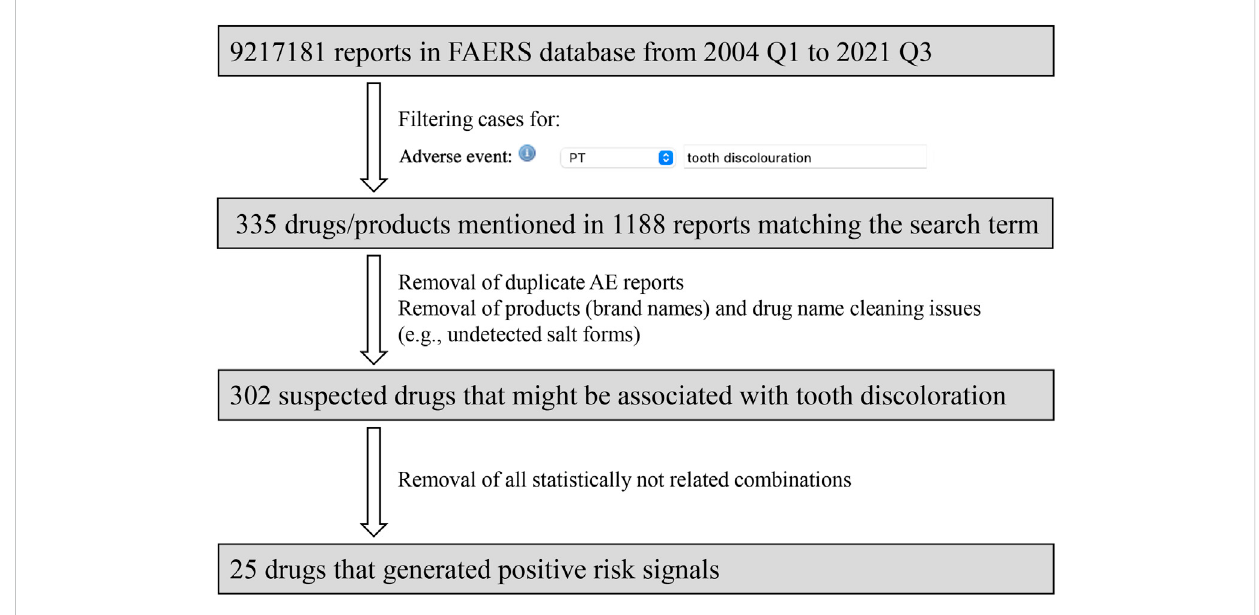
FIGURE 1 Flow diagram of drug identi fi cation in the FAERS.